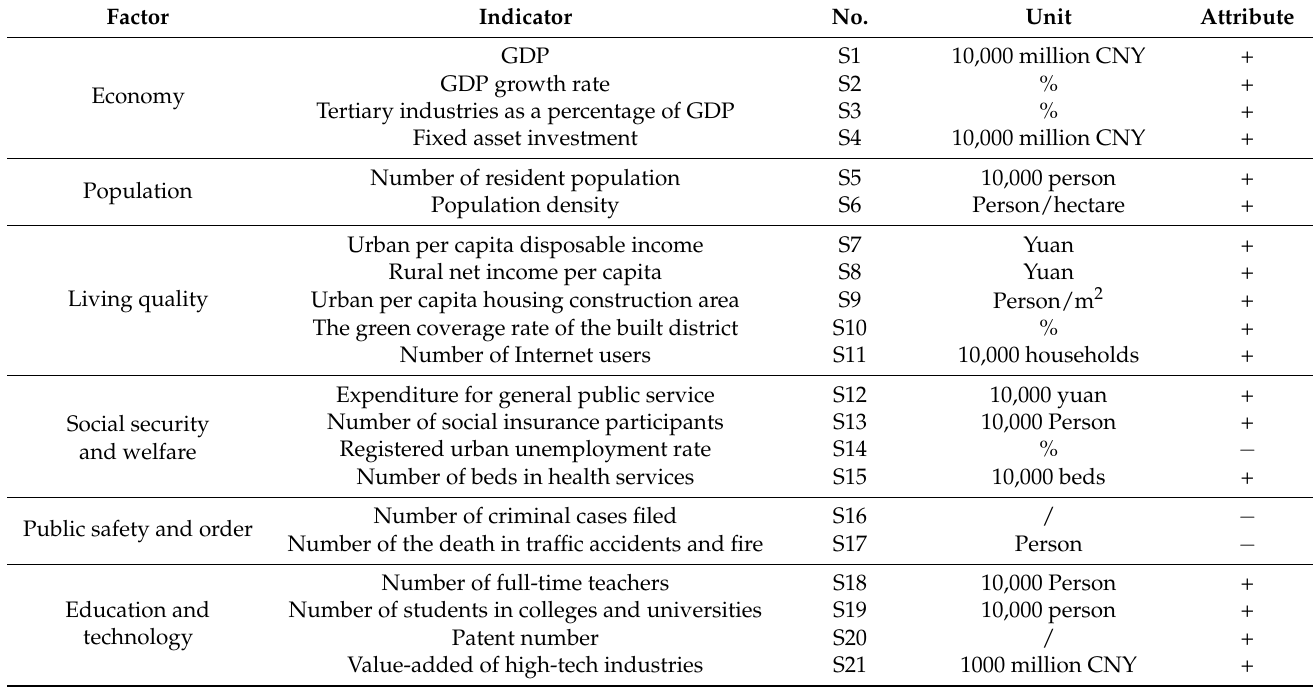
Table 3. Social comprehensive development index (SCDI) evaluation